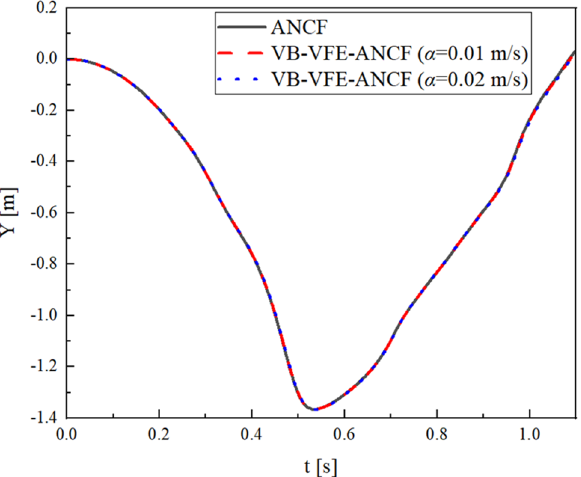
Figure 6. Comparison of the proposed method and conventional method ANCF using free-falling model (model 0) which is widely-used as a flexible beam problem. These results are in good agreement with the results shown in Refs. 27–29